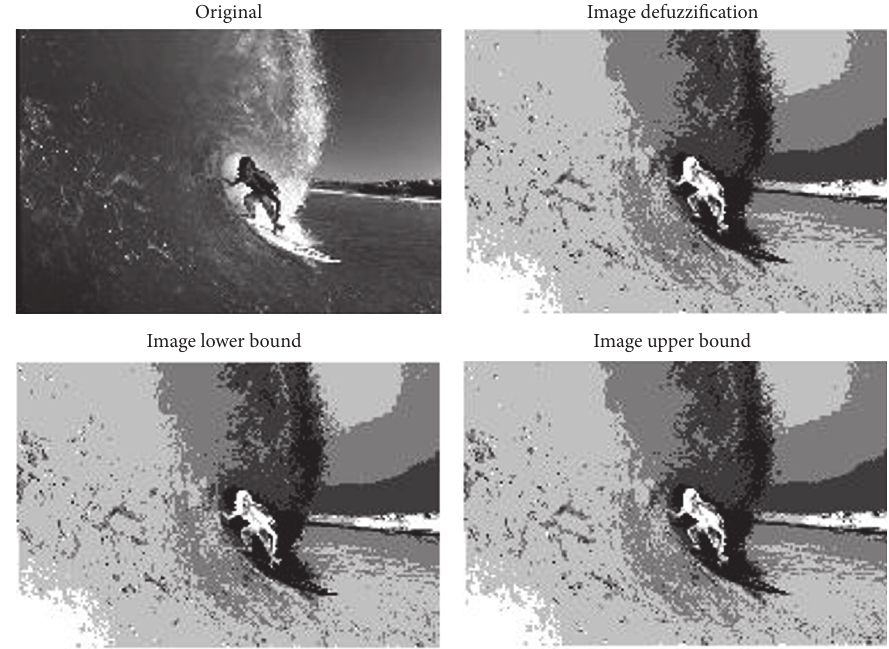
Figure 5: Resulting image clustering performed by the IT2FPCM algorithm for 5 clusters to Figure 2(c) because of the gray levels containing the image. Table 33: Results of the IT2MPE-DMFP validation index to data clustering of image shown in Figure 2(c) using IT2FPCM and